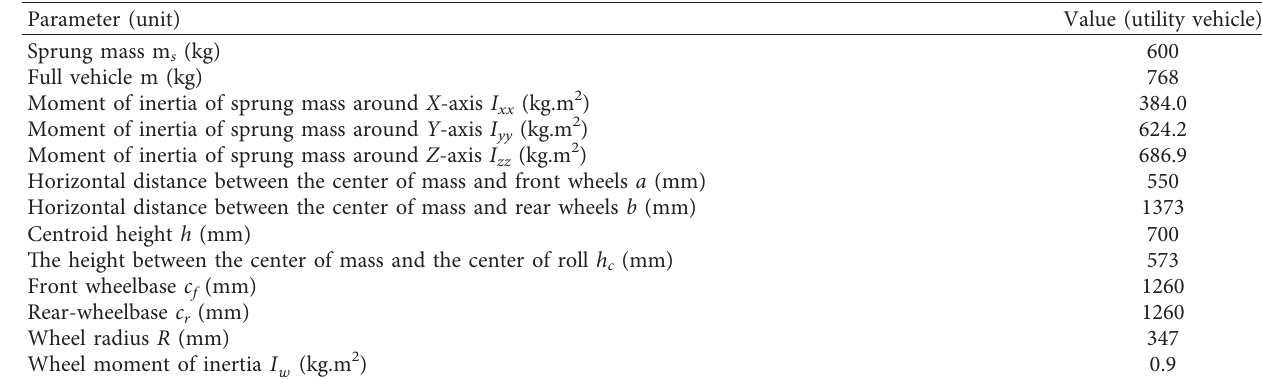
Figure 2: (a) Twenty-seven DOFs vehicle model. (b) CarSim vehicle structure. Table 2: Vehicle simulation parameters [21,